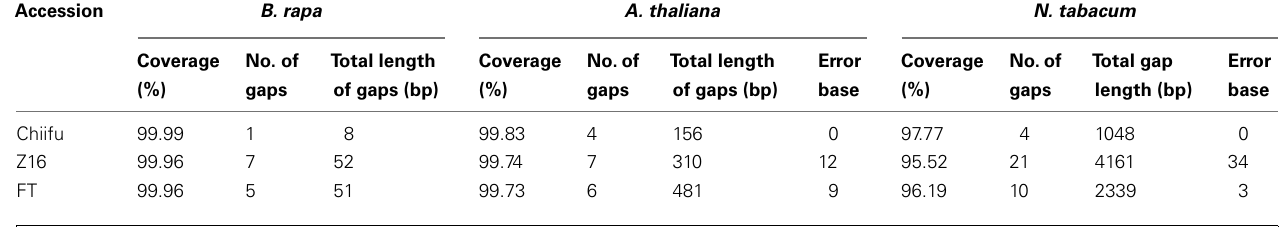
Table 2 |Assembly of chloroplast genomes of three B. rapa accessions guided by cp genome sequence of B. rapa (DQ231548), A. thaliana (NC000932), and N. tabacum (NC001879).